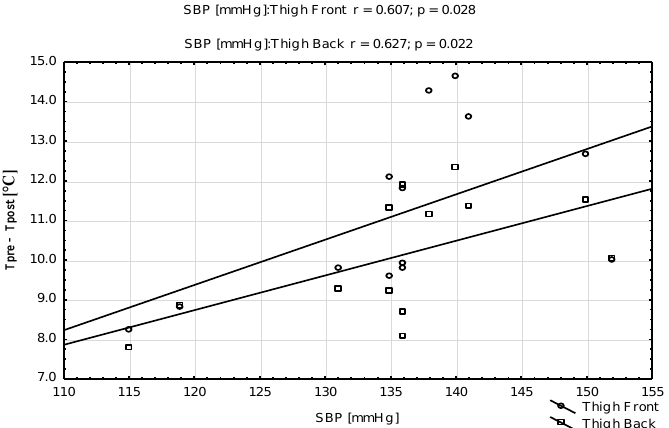
Figure 8. Relationship between systolic blood pressure and the magnitude of change in temperature of the anterior and posterior surfaces of the thighs.